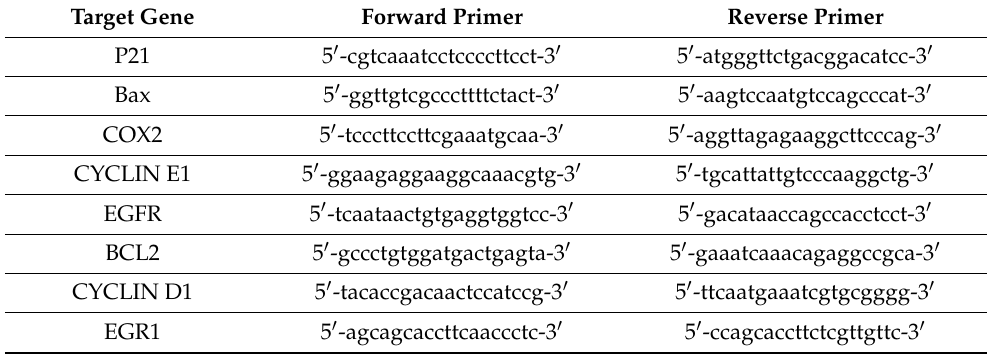
Table 1. Primer sequence of target